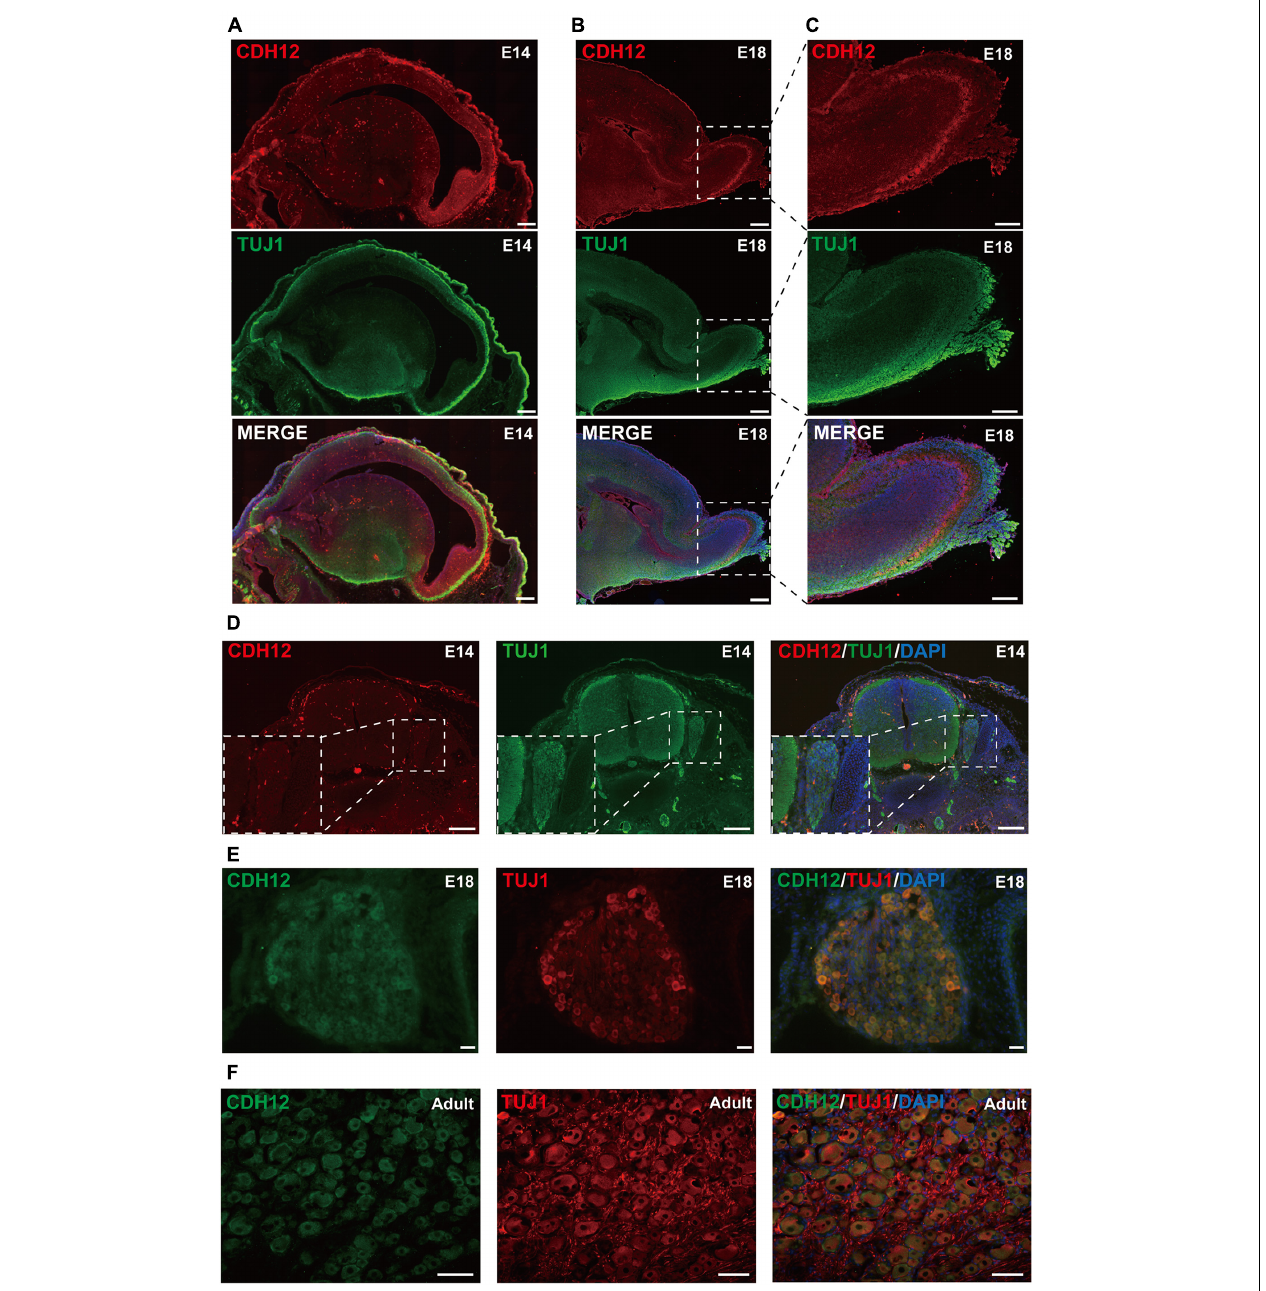
FIGURE 4 | Expression pattern of CDH12 during development. (A) CDH12 is widely expressed in the E14 brain. Sagittal sections of the E14 rat brain were stained with antibodies against CDH12 and Tuj1. The scale bar represents 500 µ m. (B) High expression of CDH12 was observed in the olfactory bulb of E18 rats. Immunostaining images of sagittal brain sections were obtained by staining with antibodies against CDH12 and tubulin. The scale bar represents 500 µ m. (C) Enlarged view of the boxed area in panel B. The scale bar represents 250 µ m. (D) Representative images of the immunofluorescence staining of CDH12 expression in the E14 spinal cord and DRG. The expression of CDH12 is limited at this development stage. The white dashed box shows an enlarged view of the DRG. The scale bar represents 200 µ m. (E,F) Representative images of the immunofluorescence staining of CDH12 expression in the E18 and adult rat DRG, respectively. CDH12 expression is upregulated in the DRG during development. The scale bar represents 50 µ